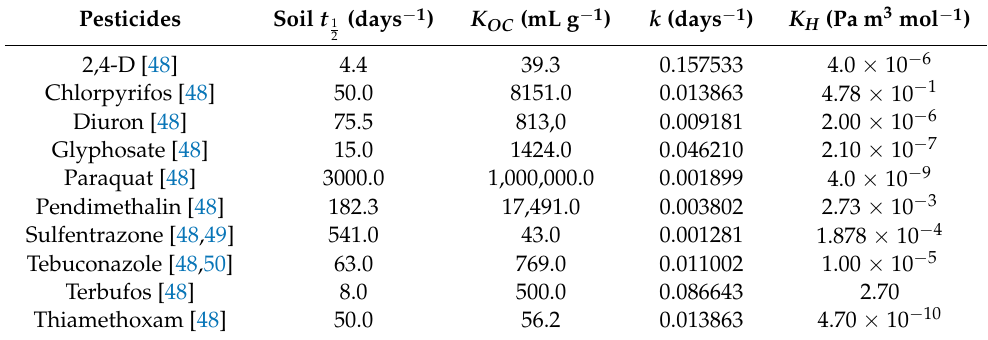
Pesticides Soil t 1